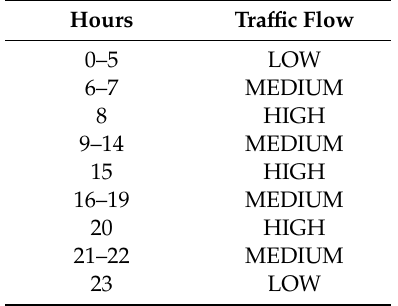
Table 1. Tra ffi c flows simulated by time of